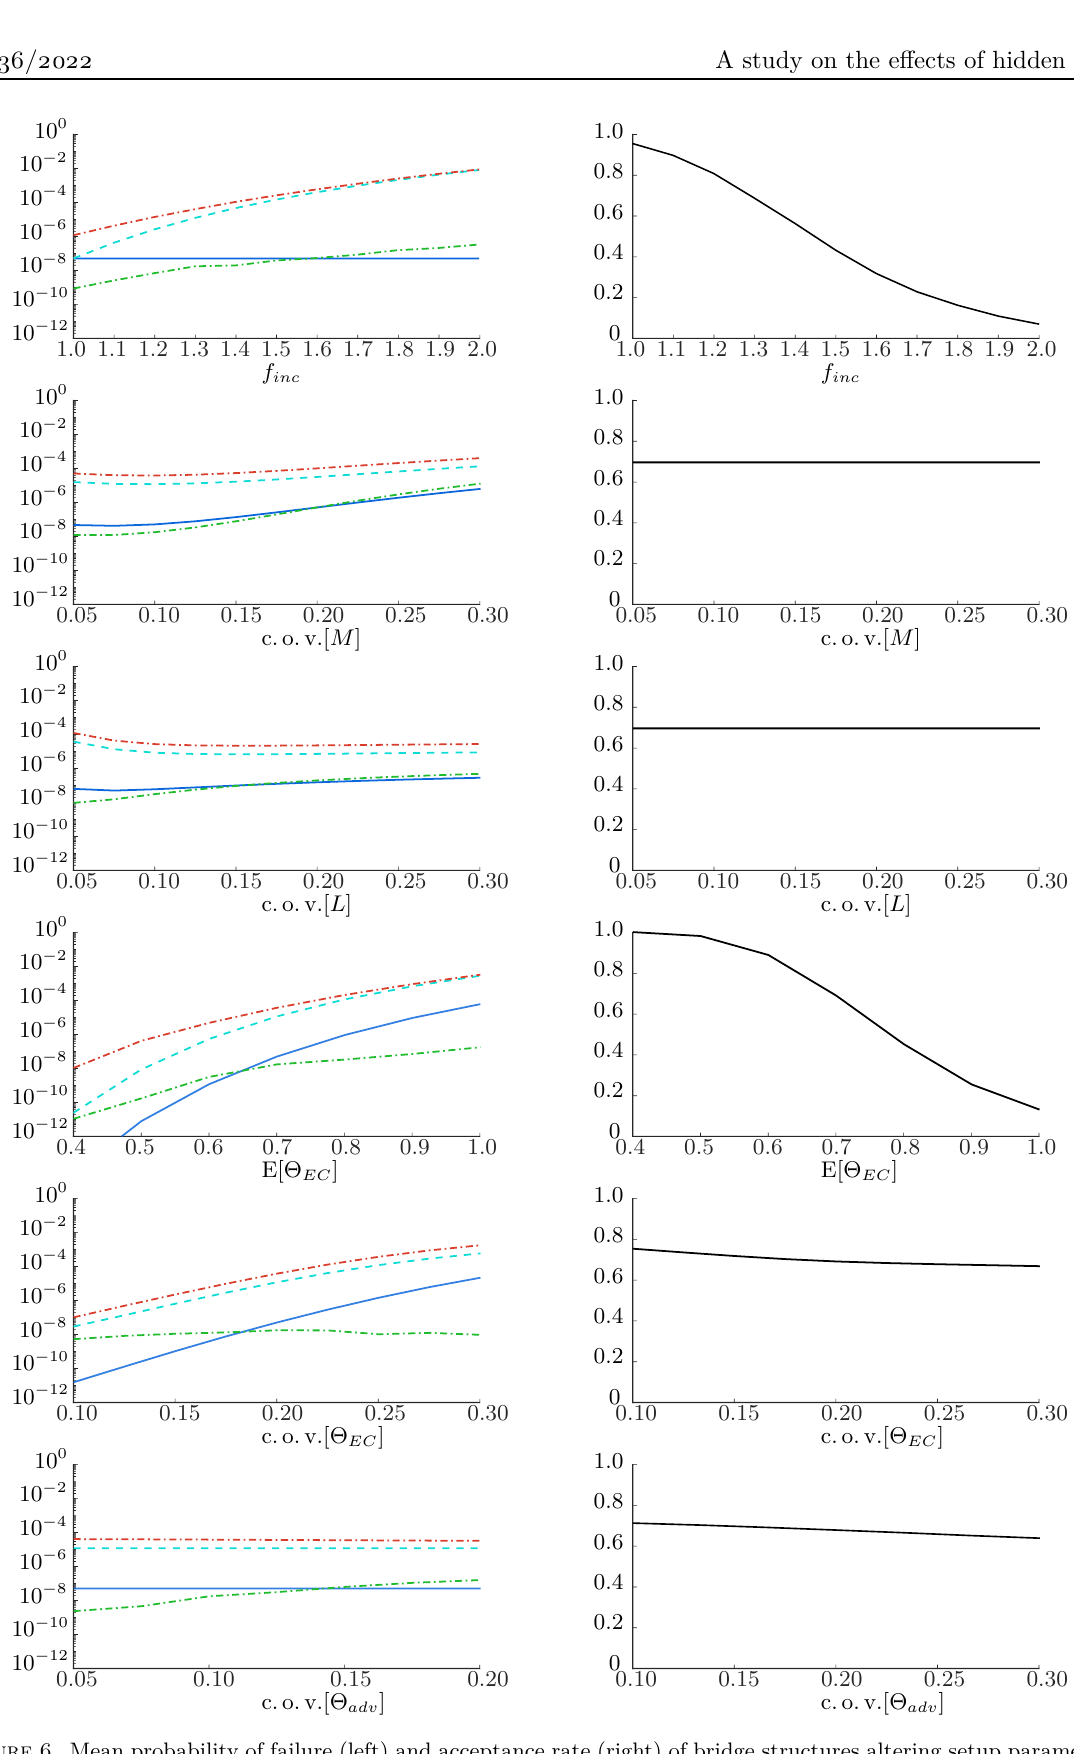
Figure 6. Mean probability of failure (left) and acceptance rate (right) of bridge structures altering setup parameters one at a time. The blue lines represent the mean probability of failure when the original load is applied (target probability of failure), the teal dashed lines represent the mean probability of failure when the increased load is applied and the dash doted green and red lines represent the mean probability of failure of the accepted and the rejected bridge